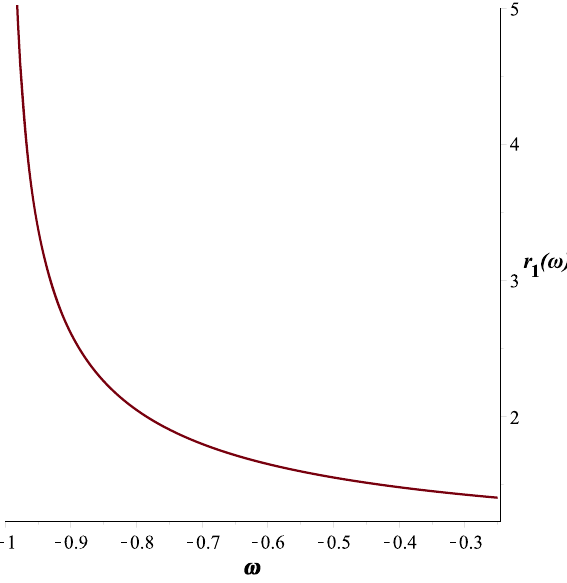
Fig. 2 F ( r ,ω) for ω = − 0 . 5 (dashed line), ω = − 0 . 7 (dotted line) and ω = − 0 . 9 (solid line) against r . It is clear that F ( r ,ω) is positive throughout some range r > r 1 which implies the NEC is satisfied. See the text for details